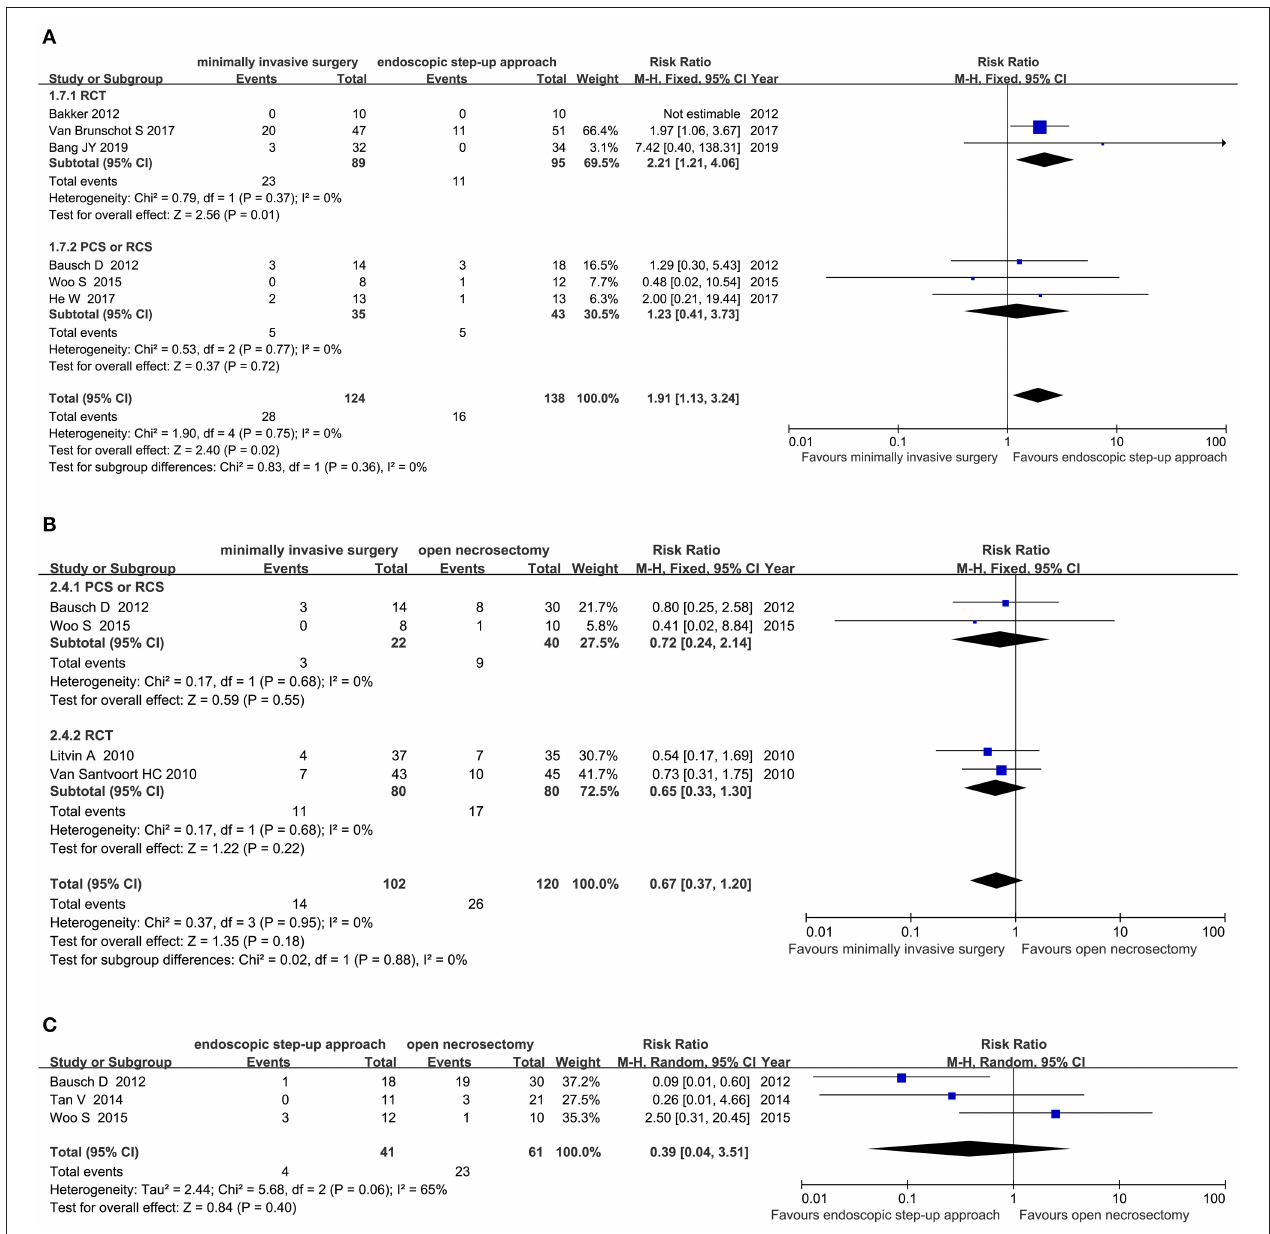
FIGURE 8 | Forest plots for the incidence of intra-abdominal bleeding. (A) Between minimally invasive surgery and endoscopic step-up approach. (B) Between minimally invasive surgery and open necrosectomy. (C) Between endoscopic step-up approach and open necrosectomy. M-H, Mantel–Haenszel test; Fixed, a fixed effects model; CI, confidence